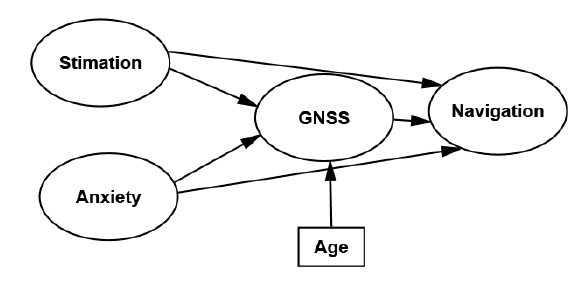
Figure 1. Proposed model on human spatial navigation attitudes towards global navigation satellite systems based on the UTAUT theory.